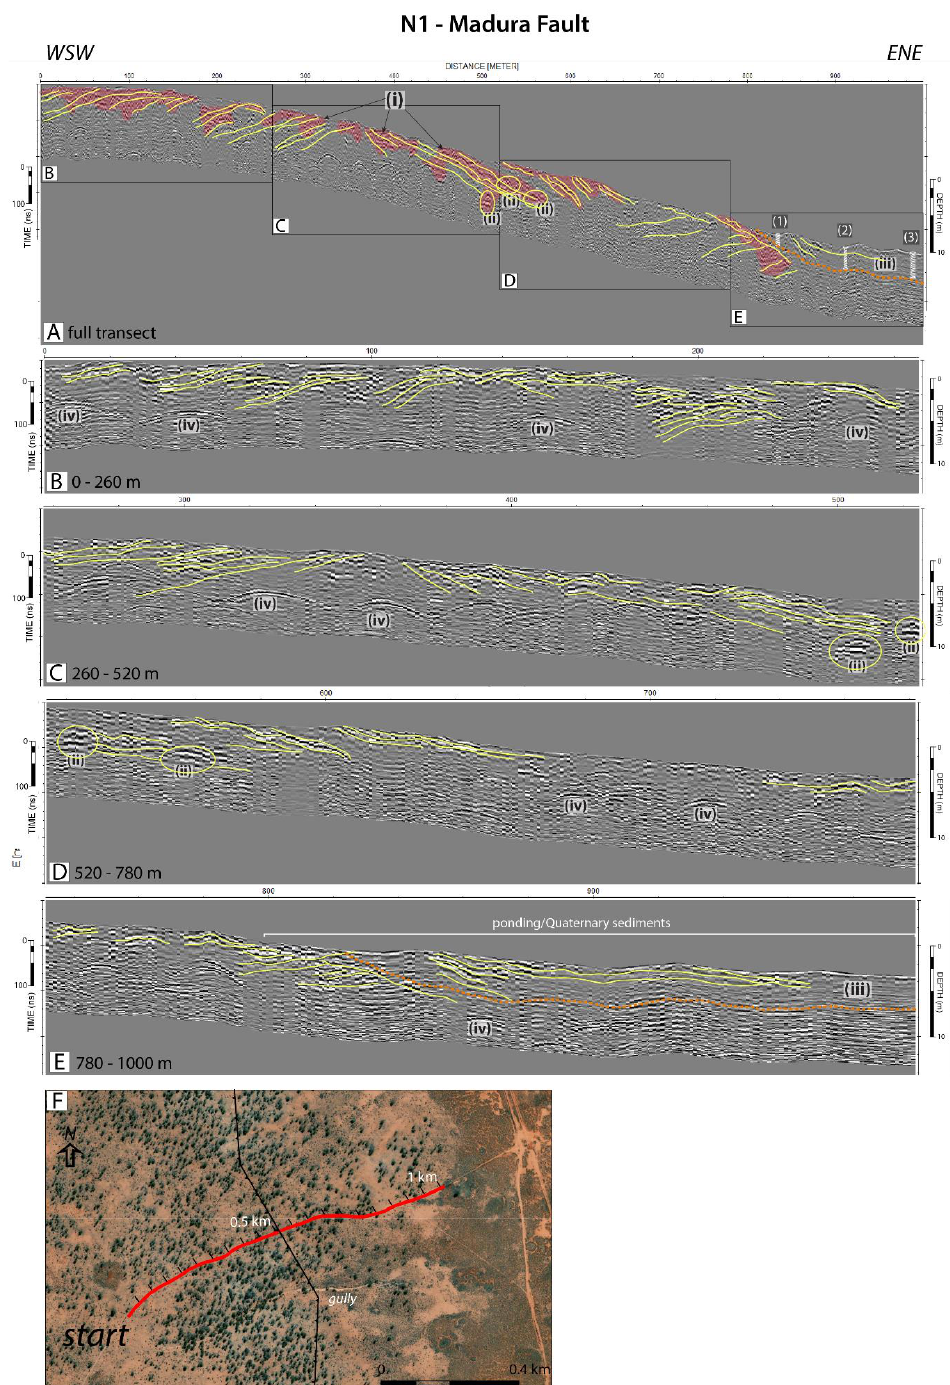
Figure 5. ( A ) Complete GPR transect N1 across the Madura fold f290 showing locations of interpreted panels ( B – E ) and some of the main features identified; (1), (2), (3): augerholes indicative of sediment thicknessofatleast1.62.m, 2.25mand2.92m, respectively; ( B – E